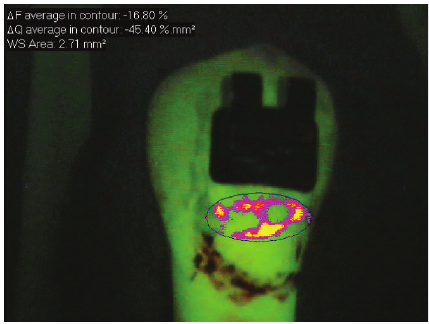
Figure 3: QLF image showing demineralized area adjacent to orthodontic